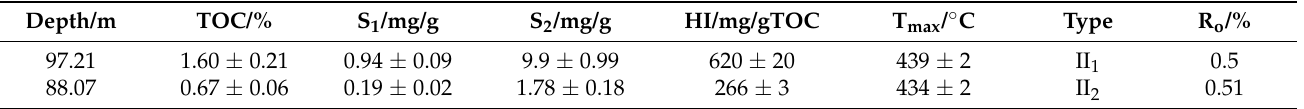
Table 1. Geochemical analysis results of source rock samples from thermal simulation experiment in Well Laikong